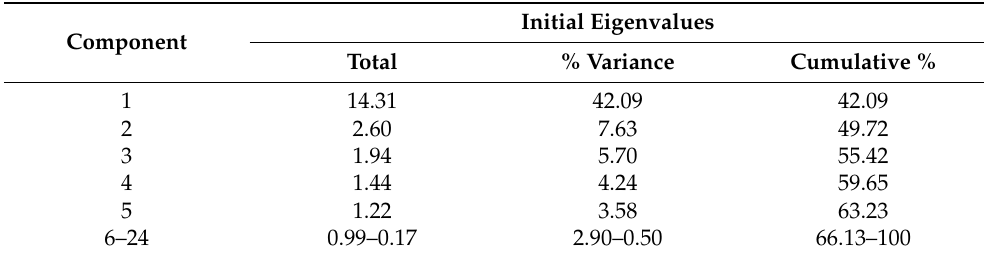
Table 1. Cumulative values of variance for five components.